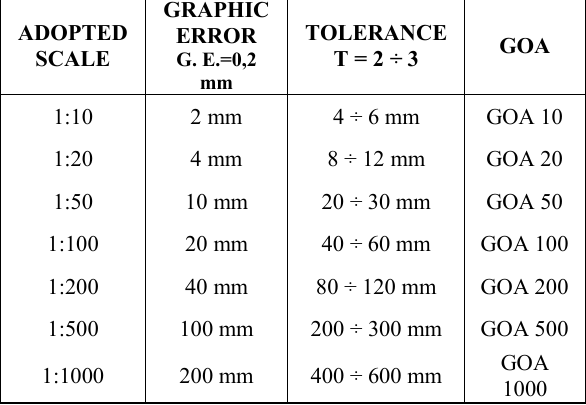
Table 1. The grade of model accuracy correspondent to the different